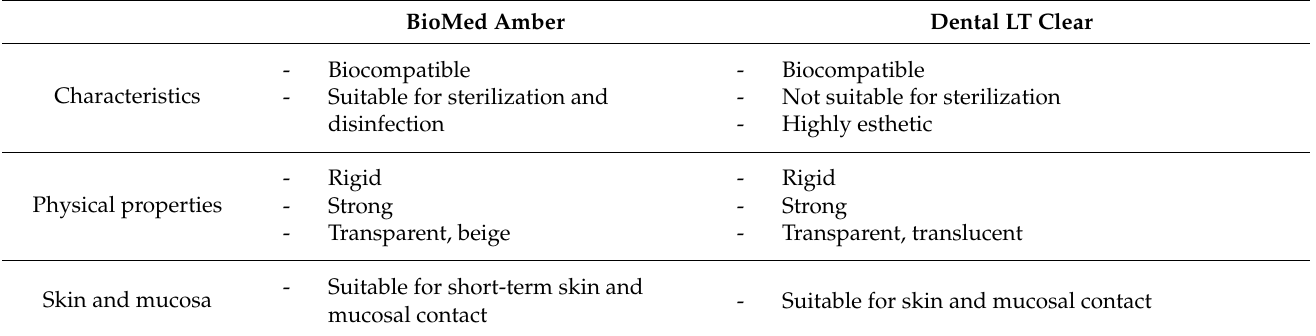
Table 1. Comparison of the properties of BioMed Amber and Dental LT Clear